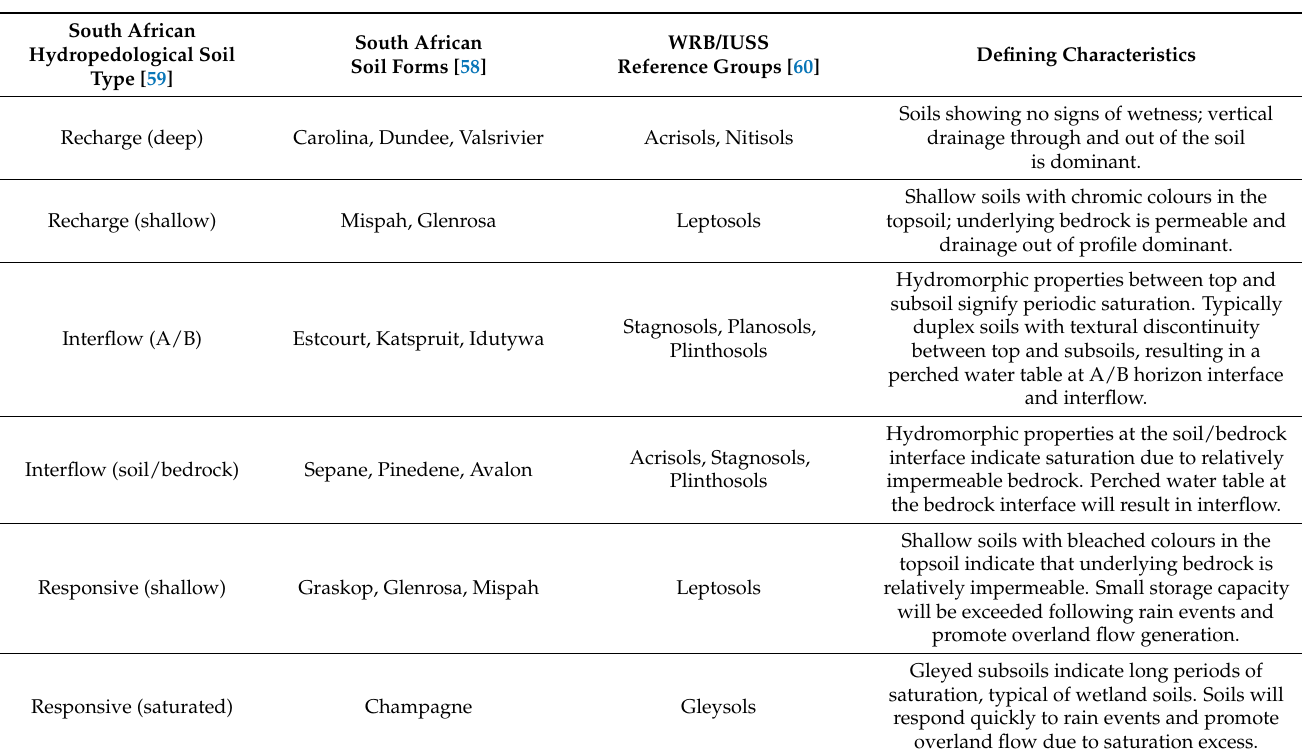
Table 3. Hydropedological soil types of South Africa, their dominant properties, and corresponding WRB, IUSS reference groups.